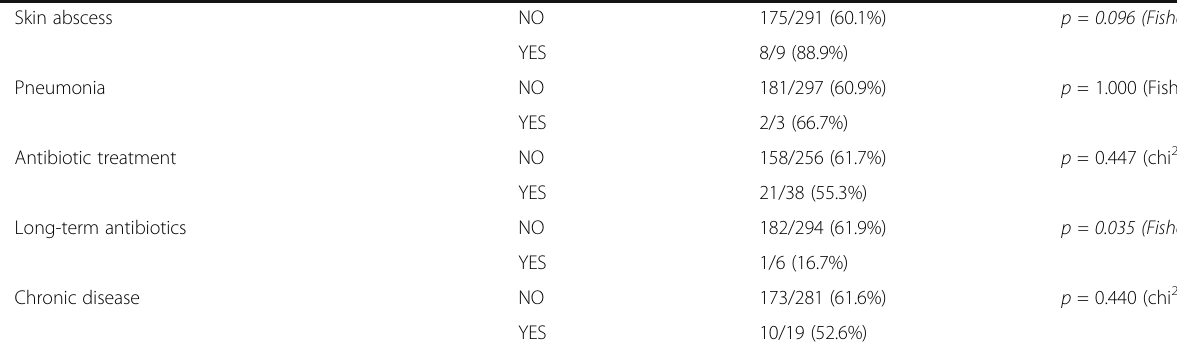
p < 0.25 value are indicated in italics . Data is presented in three parts: A. SA carriage according to sport, B. SA carriage according to hygiene practice, C. SA carriage according to medical history in the previous